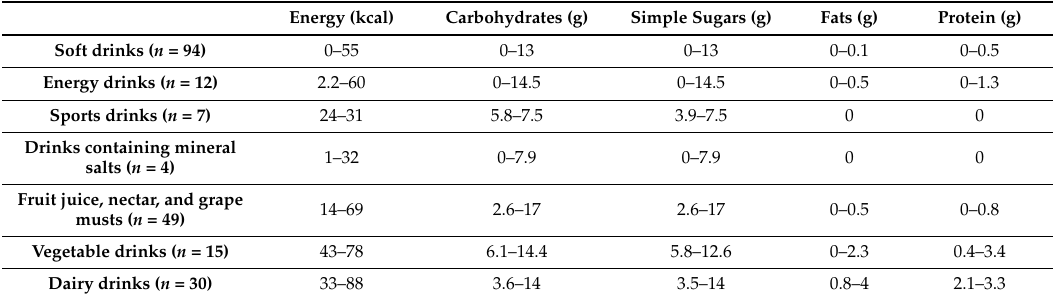
Table 1. Energy and macronutrients content (range) per 100 mL in non-alcoholic beverages groups from the Spanish